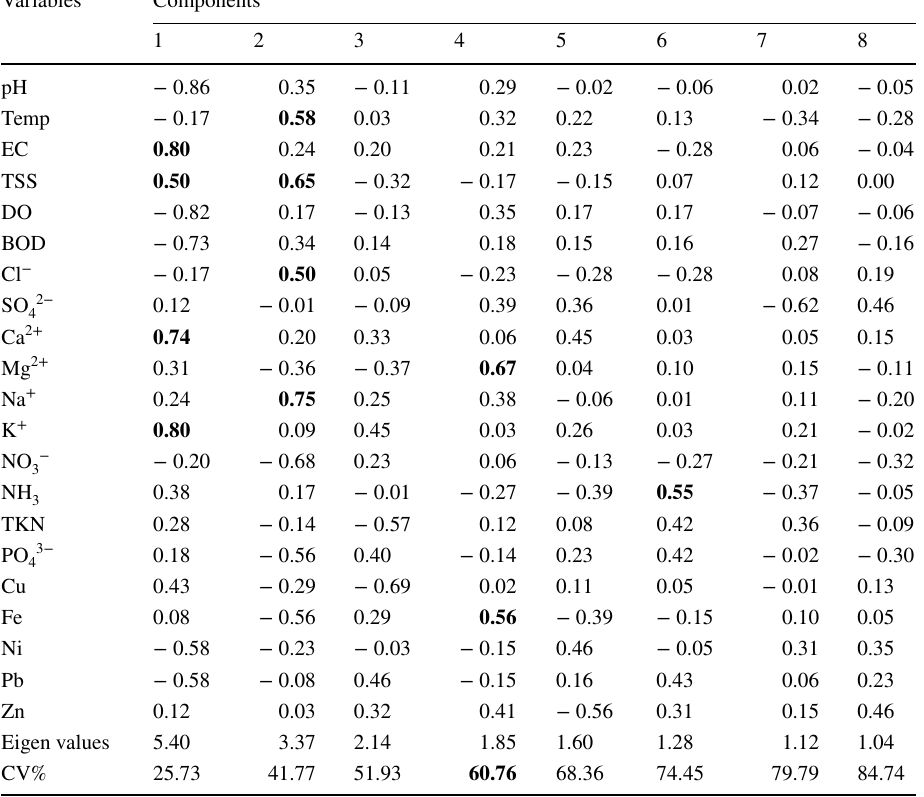
Vaues in bold represent p